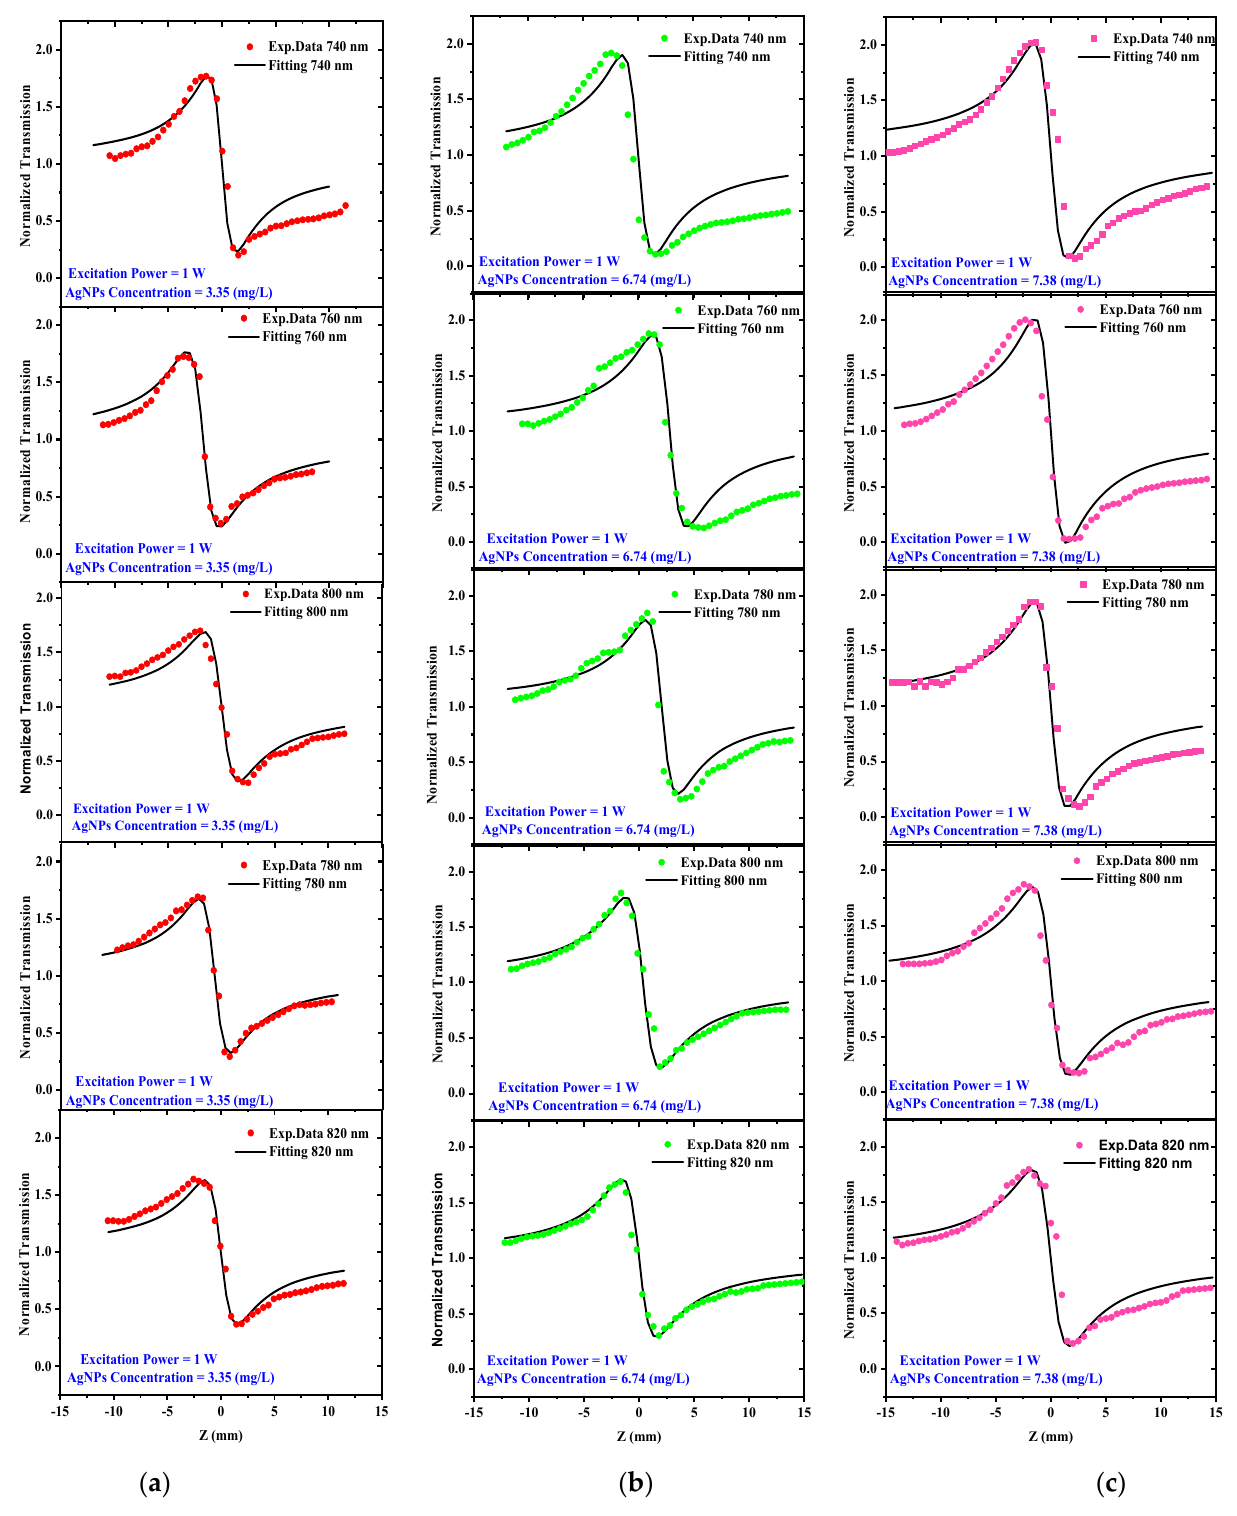
Figure 10. CA Z–scan transmission for AgNPs at 1 W excitation power, different excitation wave- lengths between 740 and 820 nm, and various AgNP concentrations of ( a ) 3.35 (mg/L), ( b ) 6.74 (mg/L), and ( c ) 7.38 (mg/L).